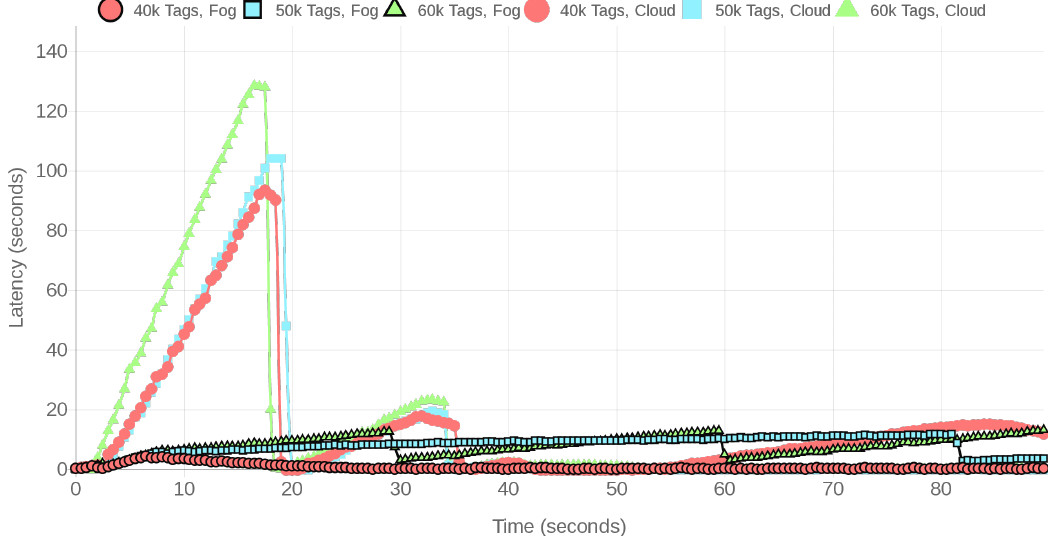
Figure 22. Latencies for the fog and cloud based systems under high loads. Table 3. Fog and cloud average latencies under high loads (in